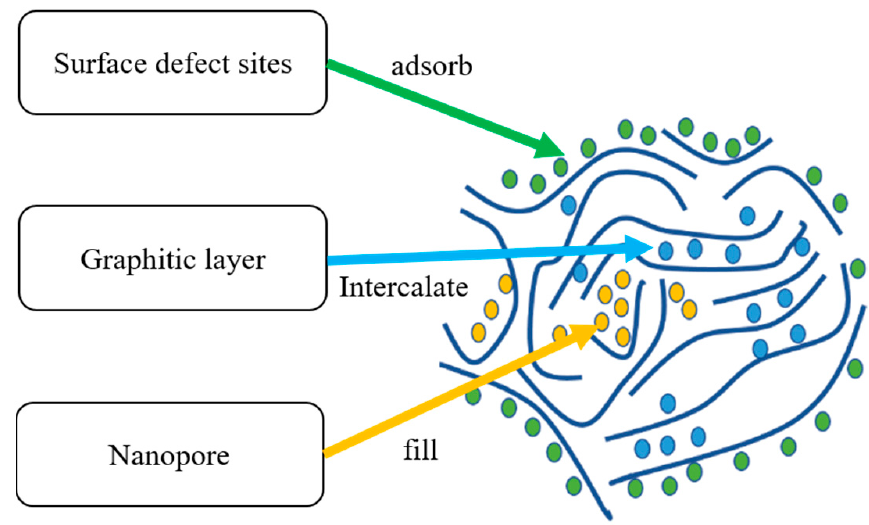
Figure 1. Mechanism of sodium ion storage in HC anodes [40].